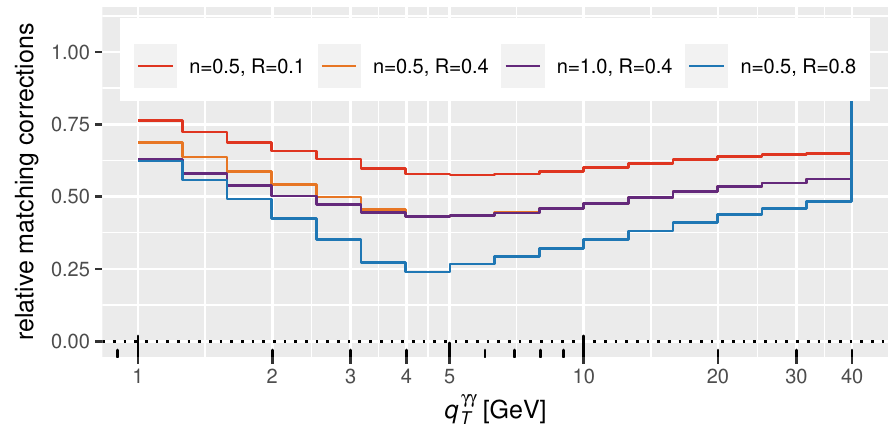
Figure 15. Diphoton maching corrections at N 2 LL relative to naively matched results with cuts as in table 4, but for different choices of the photon isolation parameters n and R